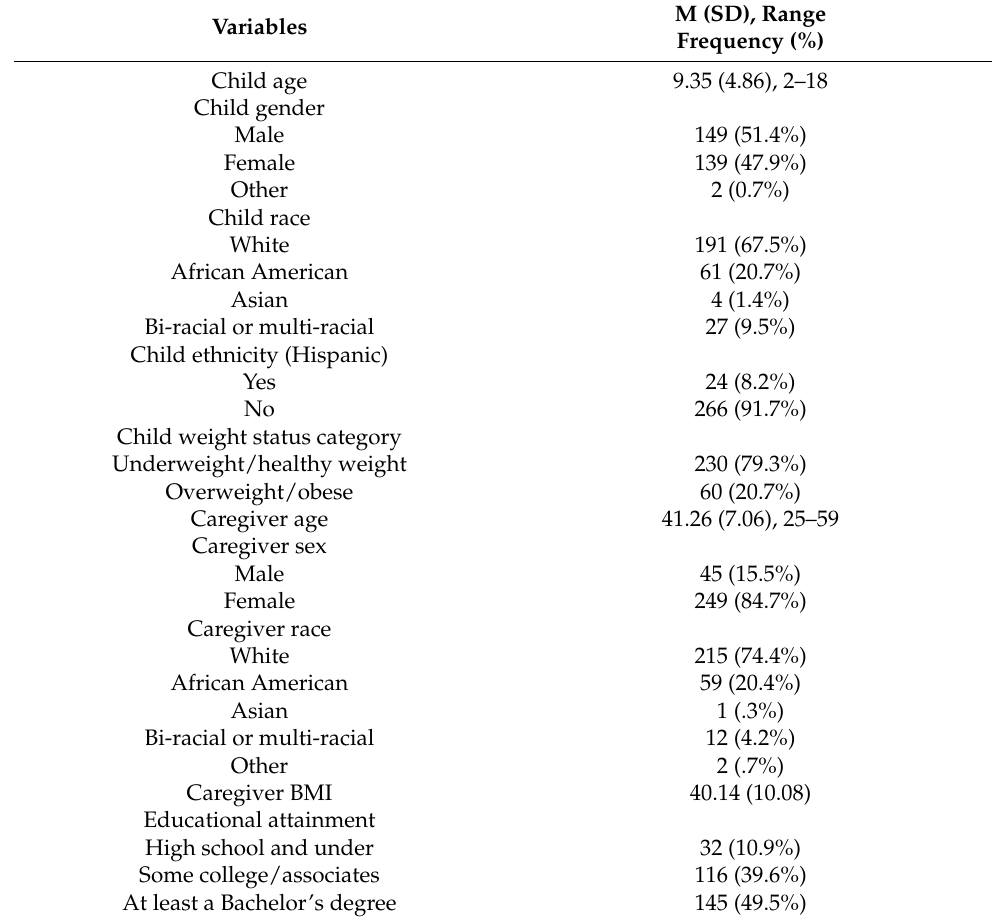
Table 1. Sample Demographics ( n =